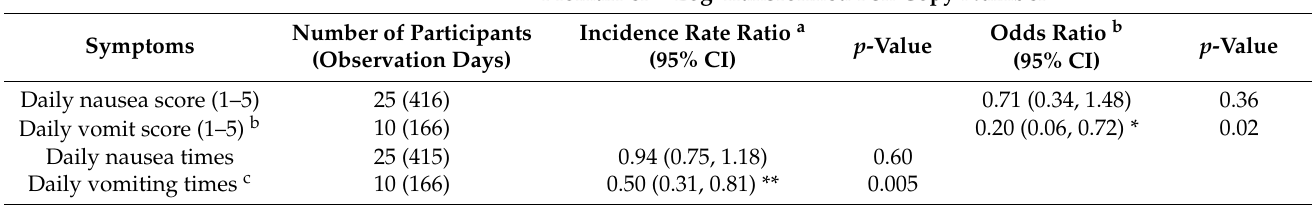
Table 4. Association between bsh copy number on Day 0 and nausea and vomit in ITT population, based on generalized linear mixed-effects models. Fixed effects included probiotics, gestational age, bsh at Day 0, and its interaction between probiotics. Interaction between bsh and probiotics was removed from the final model due to no significance. ** indicates p < 0.01, * indicates p <